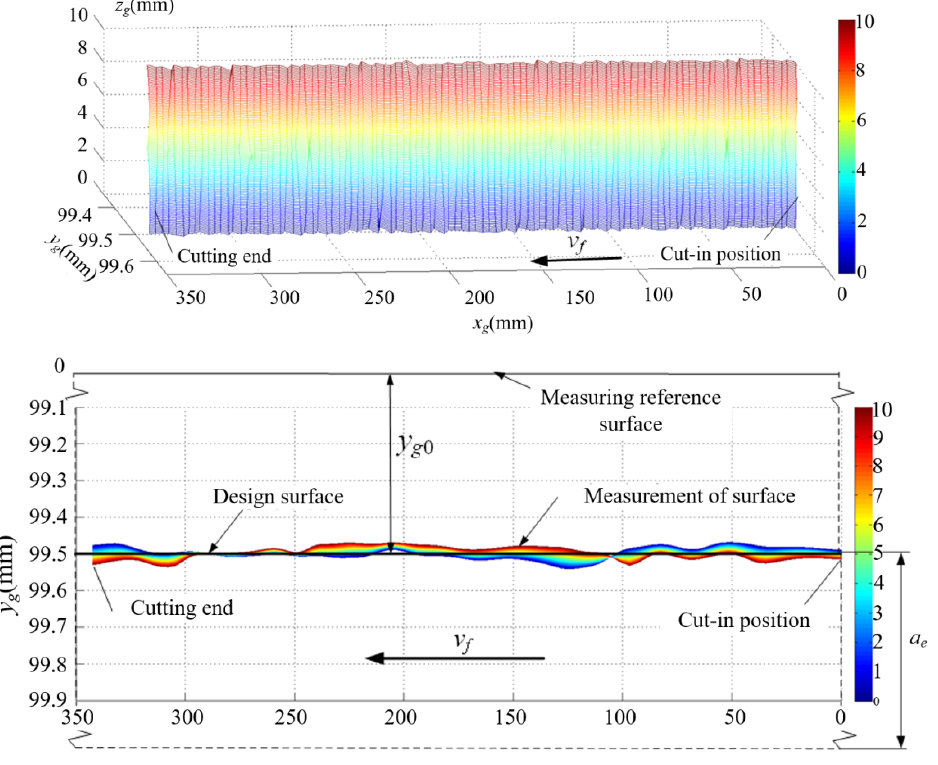
Figure 7. Simulation results of machined surface morphology.